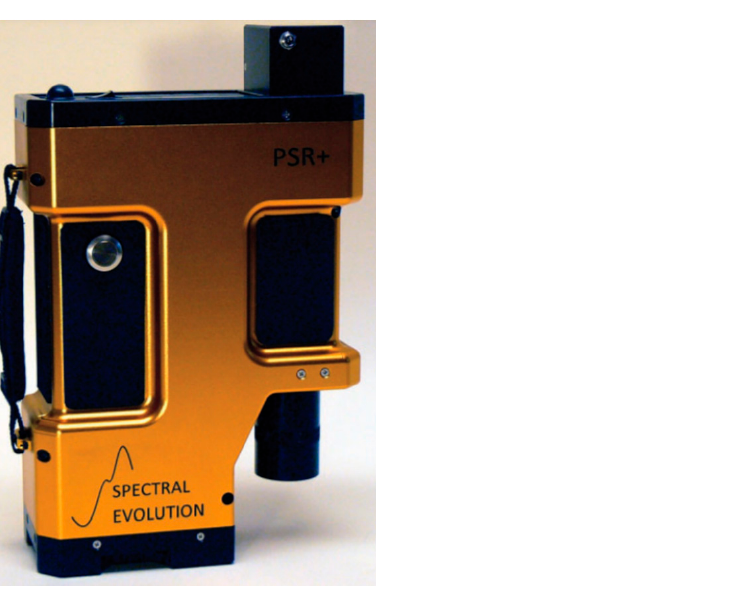
Figure 2. A portable UV–Vis–NIR (250–2500 nm range) spectroradiometer for field geology, repro- duced from [41], Copyright 2022 Portable Spectrosopy.